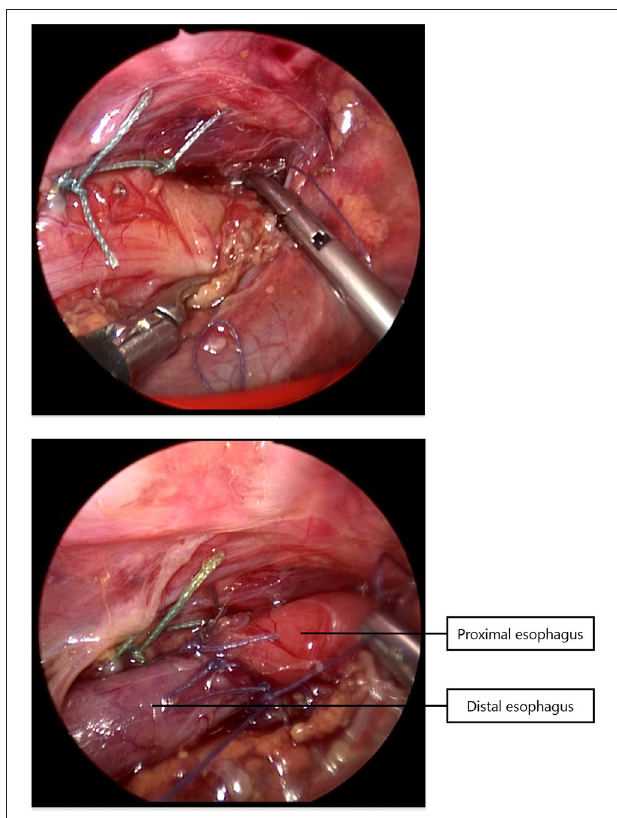
TABLE 1 | Patient characteristics of group 1 and group 2.